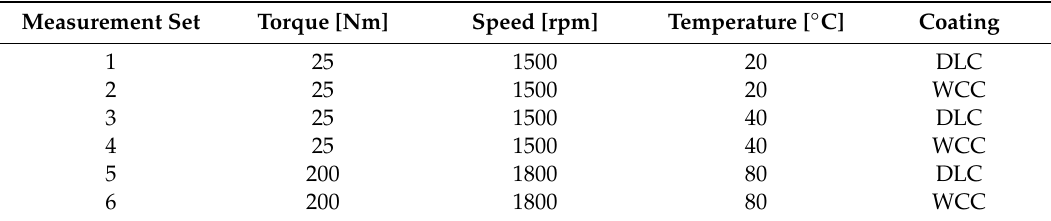
Table 3. Pin-on-disc measurement